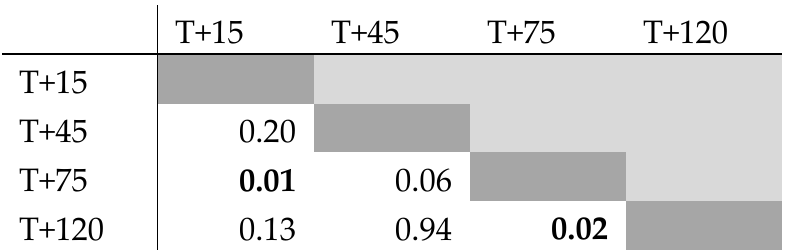
Figure 3. The results of the Wilcoxon signed rank test matrix between all measurement points of this study ( n = 19). The two measurement moments with a significant ( α = 0.05) difference are in bold . A Holm–Bonferroni correction showed that these two points are susceptible to Type I error, however.